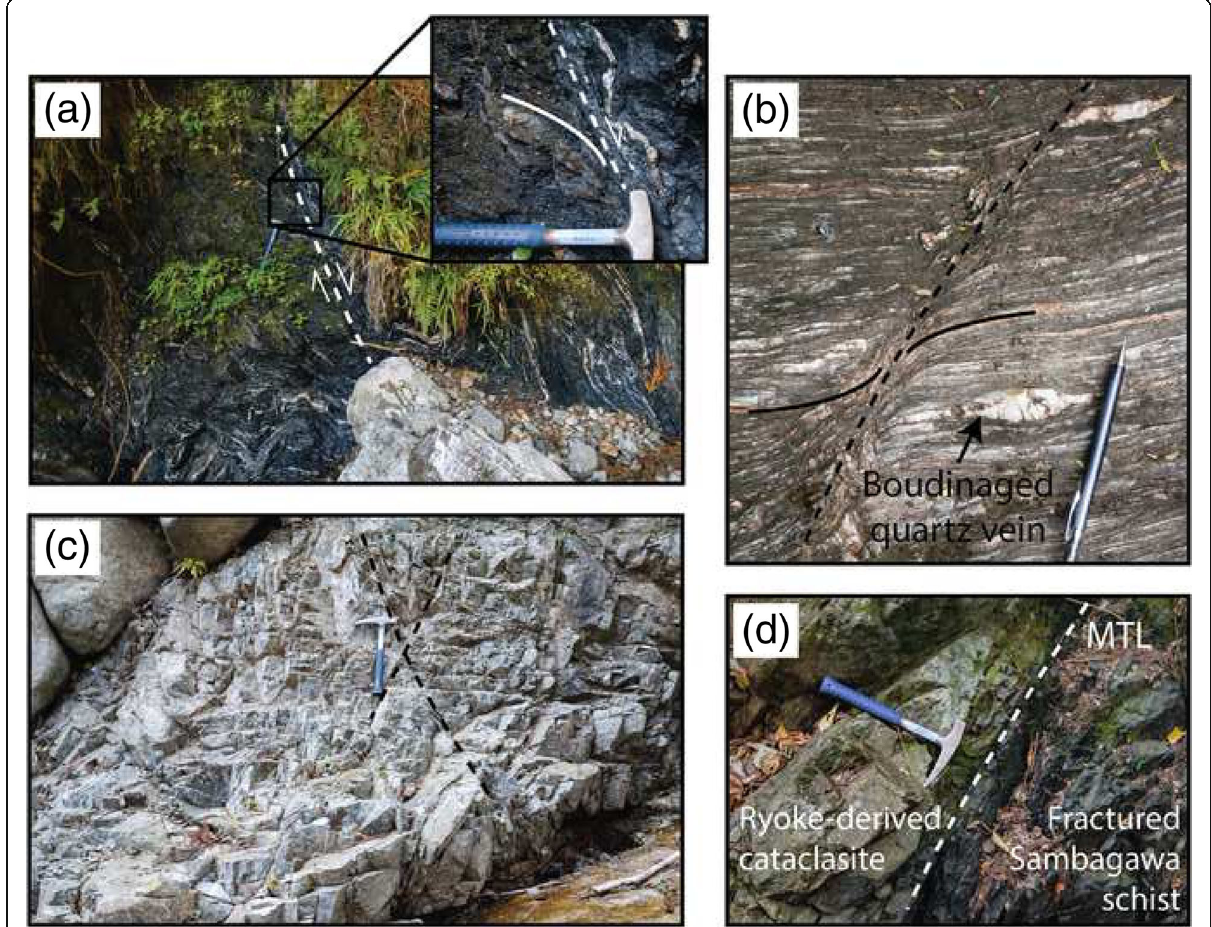
Fig. 3 Photographs showing MTL fault rocks in outcrop. a Outcrop of the Sambagawa schist in the Tsukide area. A north-dipping normal fault is shown, with fault-drag folds visible in the inset. b Small-scale ductile shear zone in the Sambagawa schist in the Ako – Miyamae area. The shear zone is traceable for ~ 2 m and has an offset of ~ 4 cm. c Outcrop of highly fractured protomylonite from ~ 350 m north of the MTL. A pair of conjugate fractures are indicated by black dashed lines. d Outcrop of the MTL in the Ako – Miyamae area. At this outcrop, no gouge is observed, and Ryoke-derived rocks are in direct contact with the Sambagawa